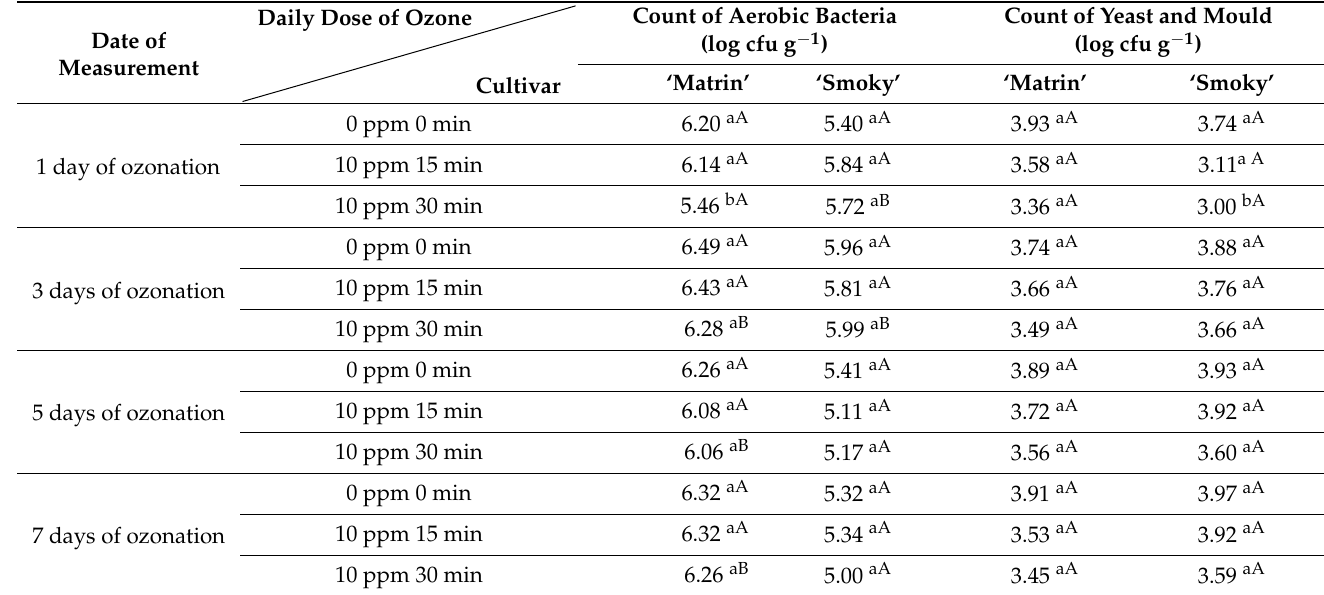
Table 1. Microbial load in saskatoon berries on the first, third, fifth, and seventh day after ozonation relative to the duration of the treatment ( n = 3).